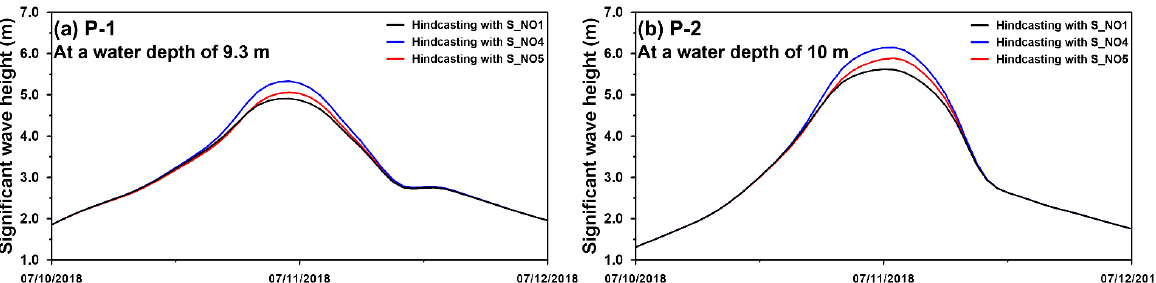
Figure 14. Time series of hindcasted SWHs for ( a ) P1 and ( b ) P2 using the S_NO1, S_NO4 and S_NO5 scenarios during the passage of Super Typhoon Maria in 2018.